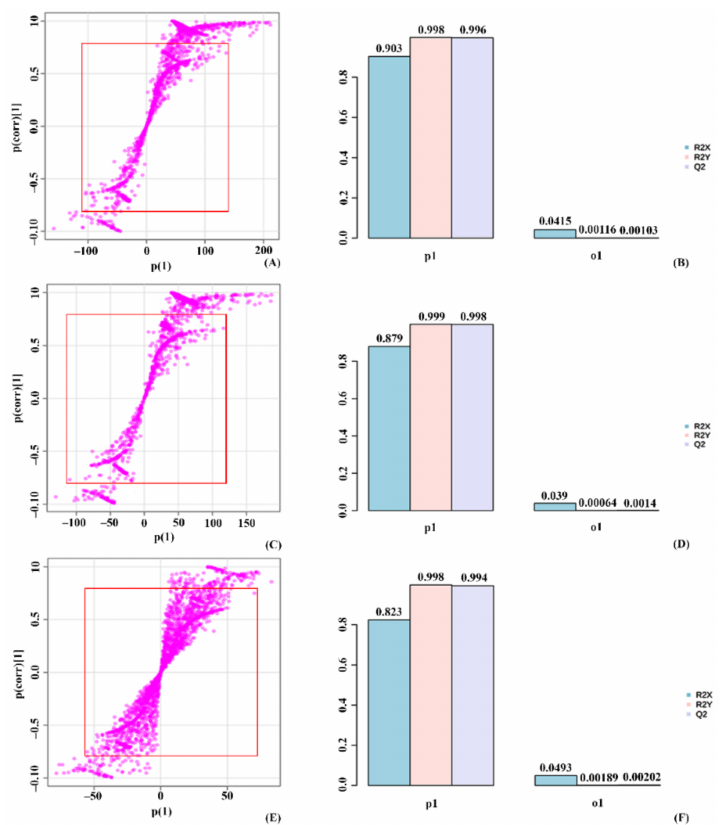
Figure 7. OPLS-DA plot grouping 10 mM stressed plants based on significantly expressed metabolites. ( A ) S-plot for control vs. treated_1, ( B ) mdsl plot with T-score and orthogonal T-score for control vs. treated_1, ( C ) S-plot for treated_1 vs. treated_2, ( D ) mdsl plot with T-score and orthogonal T-score for treated_1 vs. treated_2, ( E ) S-plot for treated_2 vs. treated_3, ( F ) mdsl plot with T-score and orthogonal T-score for treated_2 vs.